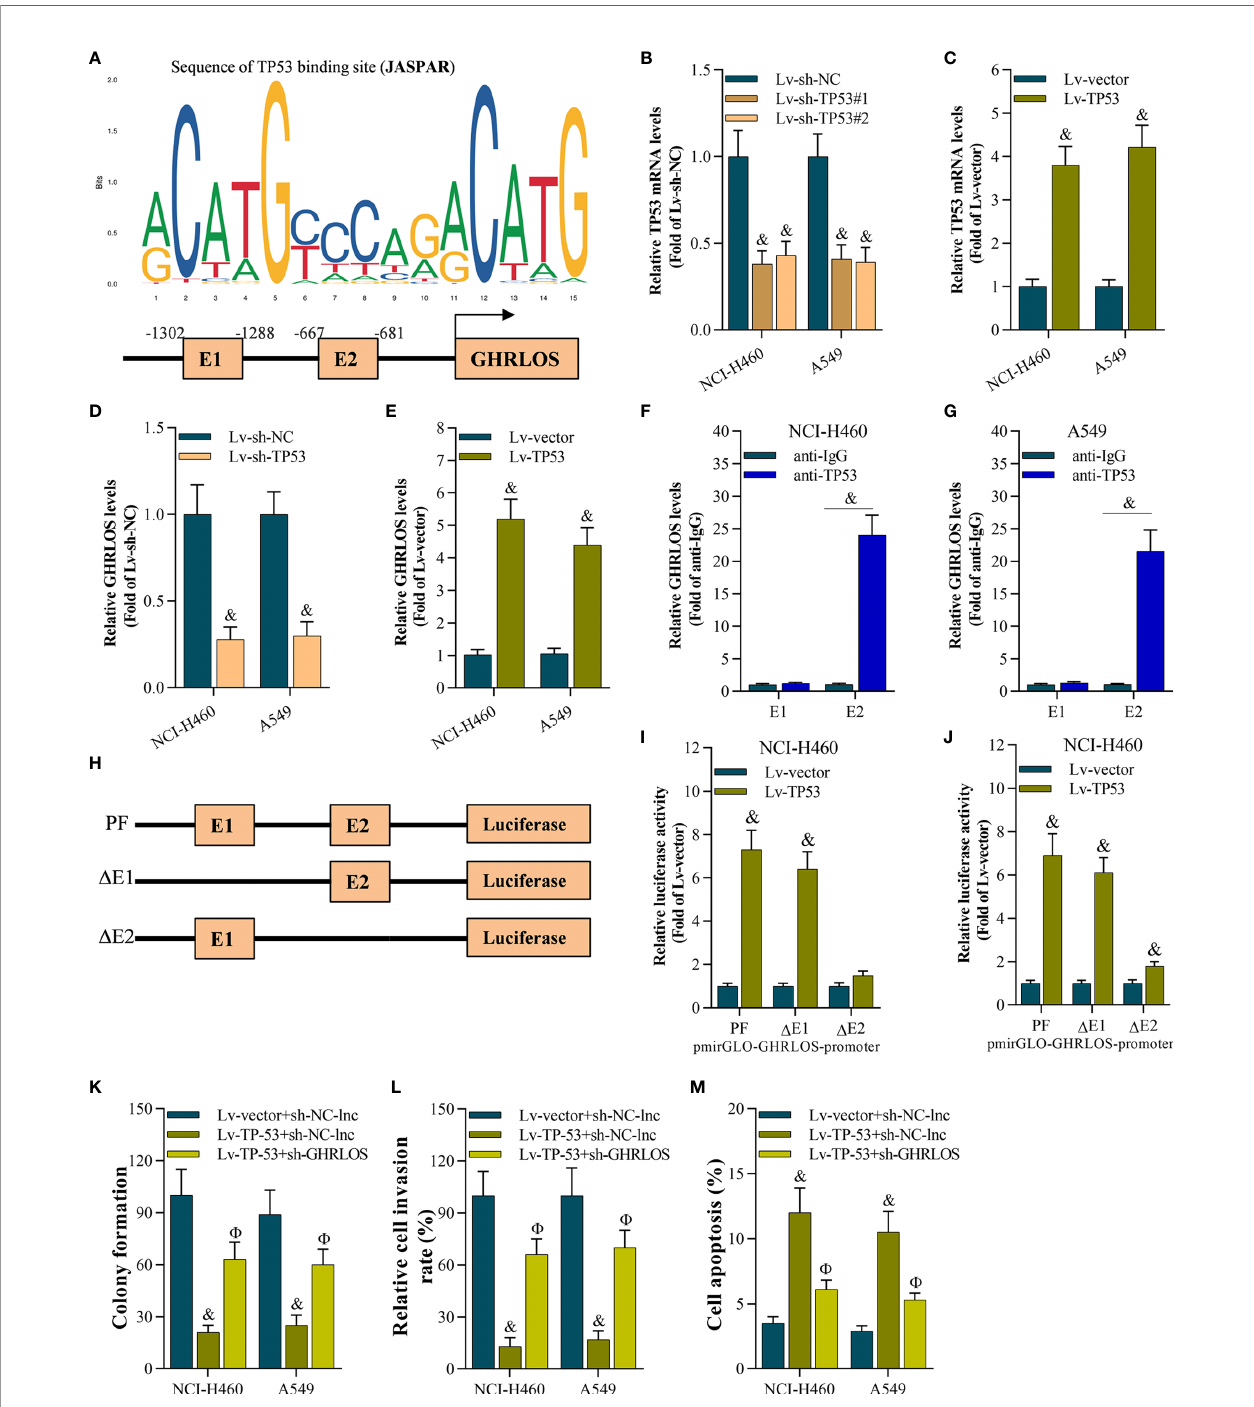
FIGURE 3 | The TP53 activated lncRNA GHRLOS transcription in NSCLC cells. (A) The predicted binding motif of TP53 in the human lncRNA GHRLOS promoter based on analysis using JASPAR. (B, C) qRT-PCR analysis of TP53 expression after knockdown or overexpression of TP53 for 48 h in NSCLC cells, &p< 0.01 vs. Lv-sh-NC or Lv-vector. (D, E) qRT-PCR analysis on lncRNA GHRLOS expression after knockdown or overexpression of TP53 for 48 h in NSCLC cells, &p< 0.01 vs. Lv-sh-NC or Lv-vector. (F, G) ChIP assays evaluated TP53 binding sites, &p< 0.01 vs. anti-IgG. (H) Schematic diagram of plasmids used for luciferase reporter assays. (I, J) Dual luciferase reporter assays examined luciferase activity, &p< 0.01 vs. Lv-vector. (K) Colony formation assay on the growth of cancer cells infected with indicated lentivirus for 48 h followed by 14 days of culture, &p< 0.01 vs. Lv-vector, Ф p< 0.01 vs. Lv-TP53. (L) Transwell assays on invasion of cancer cells 48 h after infection, &p< 0.01 vs. Lv-vector, Ф p< 0.01 vs. Lv-TP53. (M) Annexin V-FITC/PI analysis on cancer cell apoptosis after infection for 48 h, &p< 0.01 vs. Lv-vector, Ф p< 0.01 vs.